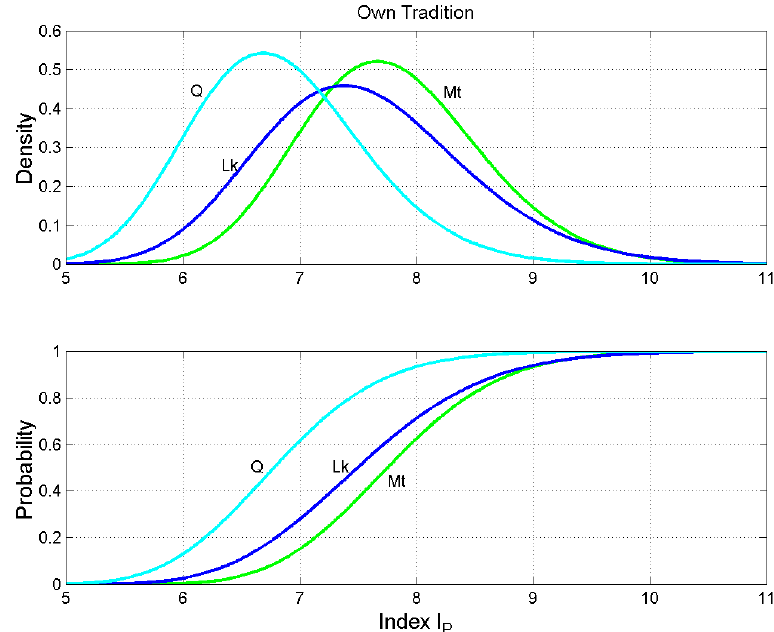
Figure 16. Own Tradition. Probability density functions (upper panel) and probability distribution functions (lower panel) of the number of words per interpunctions (word interval) I P . Matthew : green line; Luke : blue line; Q : cyan line. Table 16. Confidence levels (%) for the indicated Traditions (only Matthew and